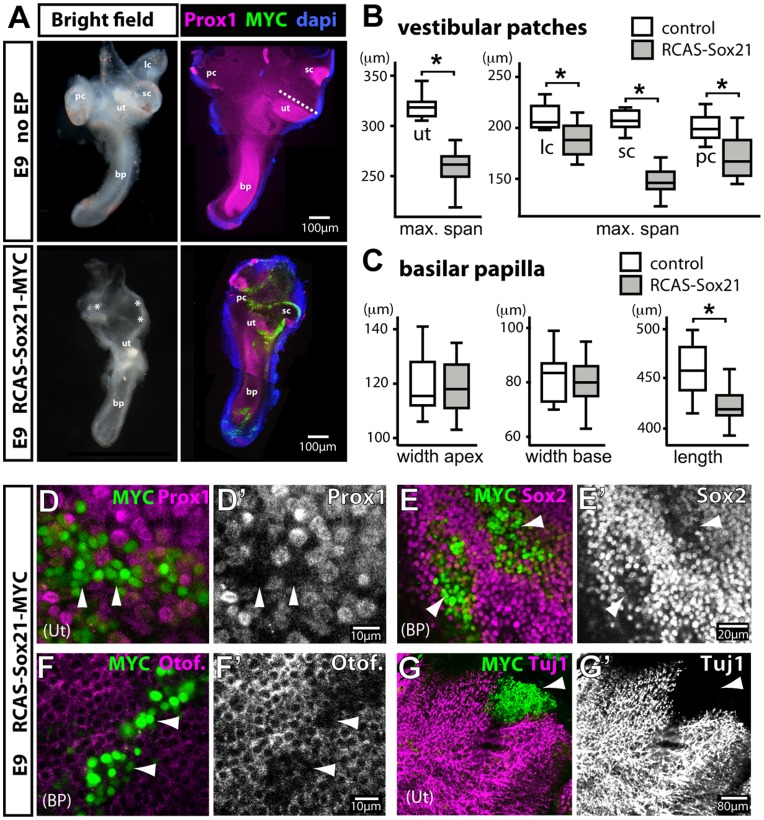
Over-expression of Sox21 at early stages of inner ear development leads to a loss of prosensory identity.(A) Brightfield and Prox1/Myc/Dapi immunostained views of inner ear dissected from E9 unelectroporated controls and RCAS-Sox21 electroporated embryos. Inner ears over-expressing Sox21 exhibit morphogenesis defects, including a reduction in the size of the cristae (white asterisks) and the presumptive utricle (marked as ”ut/sac” because identification is based on its position, and the reduced patch may also represent the saccule; images are composites of projections of distinct confocal stacks). Box plots of vestibular sensory patch maximum span (B; dashed line in panel A illustrates span of the utricle) and widths and length of the basilar papilla (C) in control (n = 12) and Sox21 (n = 13) transfected whole-mount preparations. Minimum, first quartile, median, third quartile and maximum are displayed. Prox1 (D–D’) and Sox2 (E–E’) expression is reduced in both vestibular and auditory sensory cells over-expressing Sox21 (white arrowheads). Immunostaining for otoferlin/HCA (F–F’) and Tuj1 (G–G’) show that cells over-expressing Sox21 from E2 onwards do not form hair cells or neurons and are not innervated. sc: superior crista; pc: posterior crista; lc: lateral crista; ut: utricle; bp: basilar papilla.